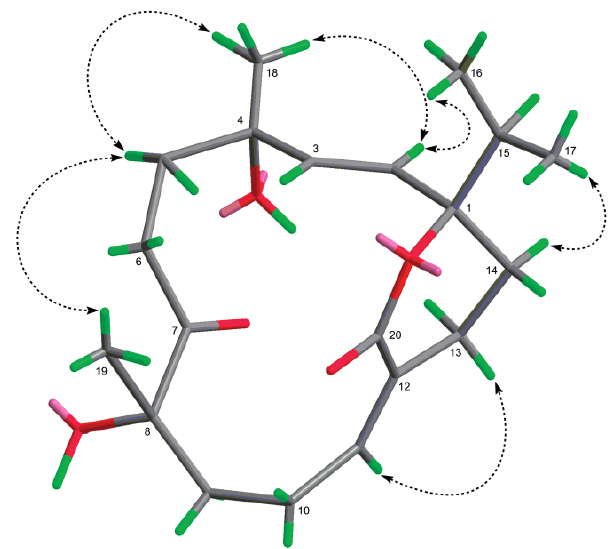
Figure 4. Selected NOESY correlations of 2 ( ↔